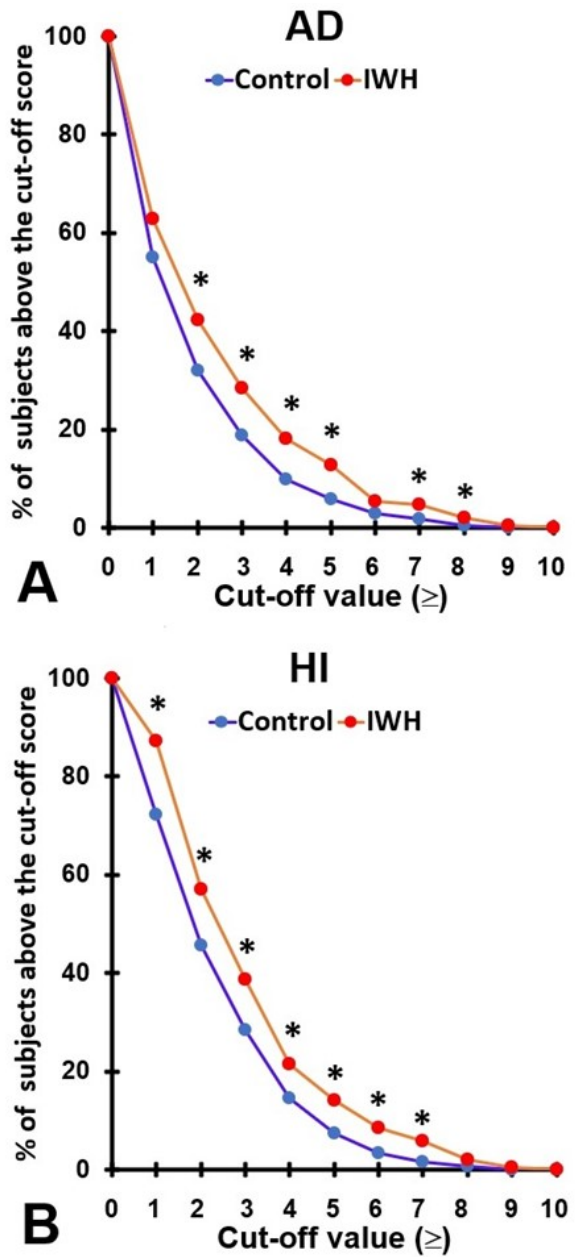
Figure 1. Percentage of subjects scoring positive for AD or HI, according to different cut-off values. ( A ) shows the results for attention deficit, ( B ) shows the results for hyperactivity, impulsivity. Significant differences between the IWH group and the control group ( p < 0.05) are indicated by *. Abbreviations: AD = attention deficit, HI = hyperactivity, impulsivity.